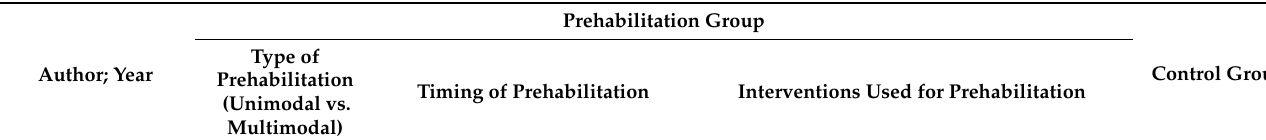
Table 2. Structure of interventions in prehabilitation programs for esophagogastric cancer